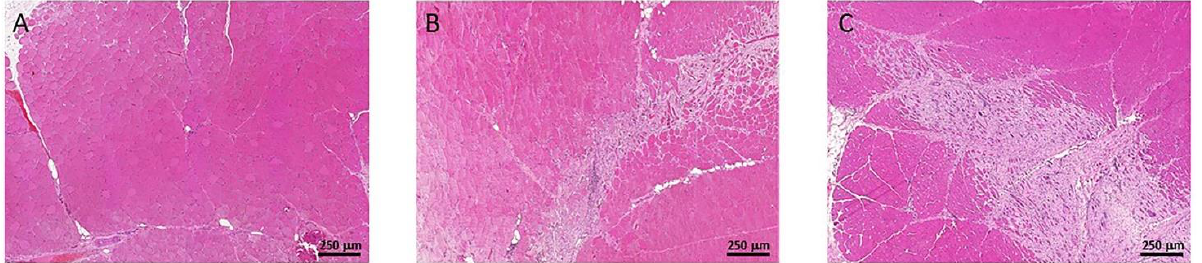
Figure 3. Hematoxylin and eosin staining example 5× showing the difference in muscular organiza- tion: ( A ) Normal Tissue, ( B ) P144 group ( C ) Placebo Group.